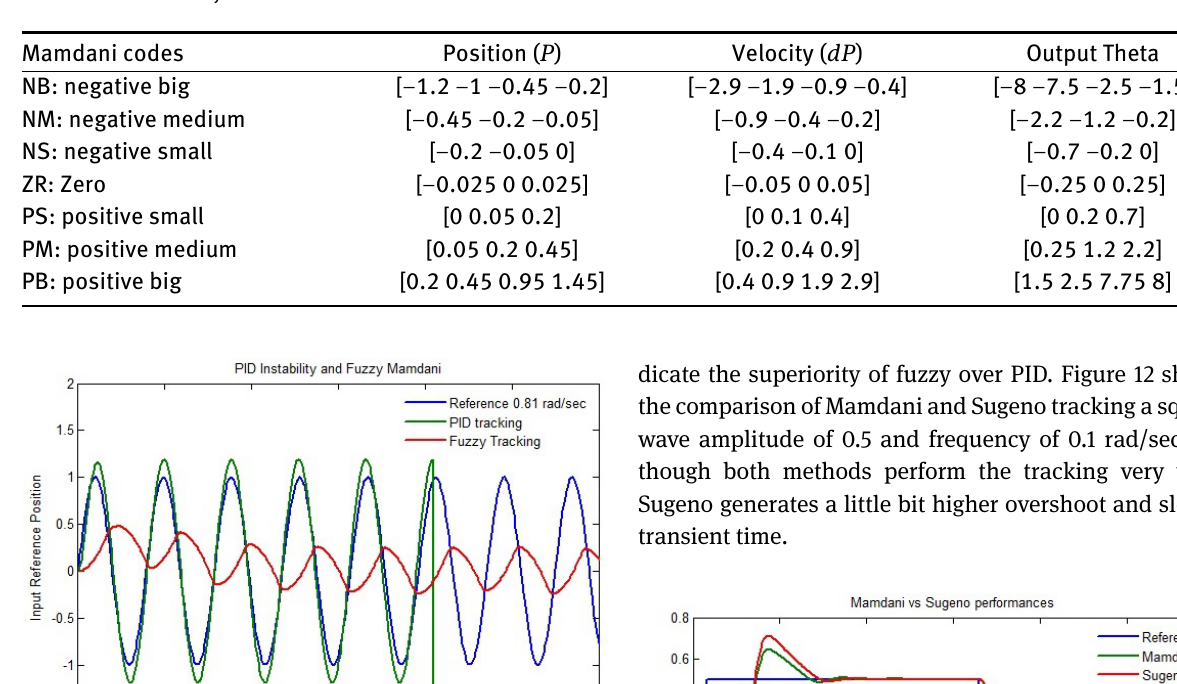
Table 1: Mamdani fuzzy rule values.